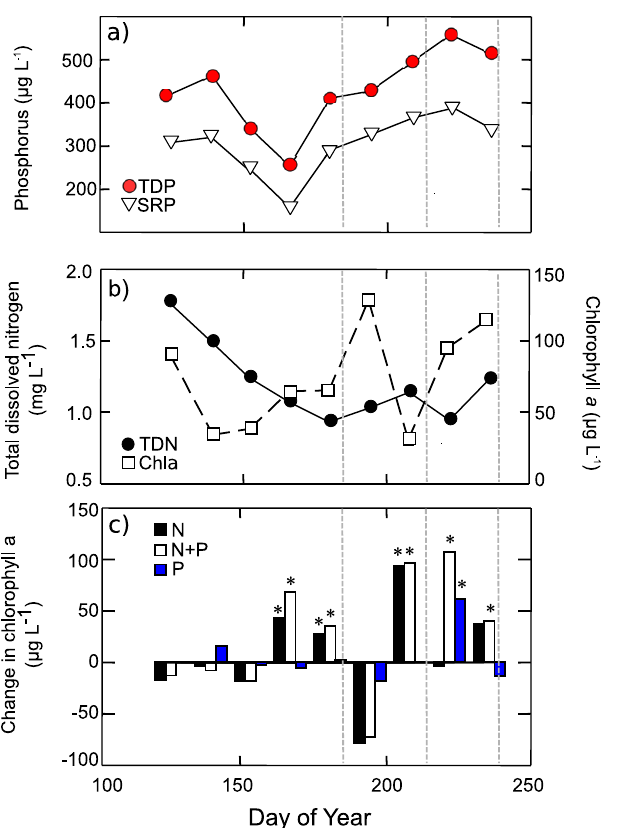
Fig 1. Seasonal limnological trends in Wascana Lake, Saskatchewan May–August 2009. (a) total dissolved(TDP) and solublereactive phosphorus (SRP) concentrations, (b) total dissolvednitrogen(TDN) concentration and phytoplankton biomass (as Chl a ), and (c) final concentrations of Chl a (fertilized treatment minus control) after 72-h bottle bioassayincubationsof Wascana Lake water receivinggrowth-saturating concentrations of NH 4 (N), PO 43- (P), or both N and P (N+P). Analysis of variance with Tukey’s post hoc tests identifiedstatistically significant(asterisk) phytoplankton biomass response( p < 0.05) relative to control bottles. Vertical dashedgrey lines show the start dates of the monthly mesocosm